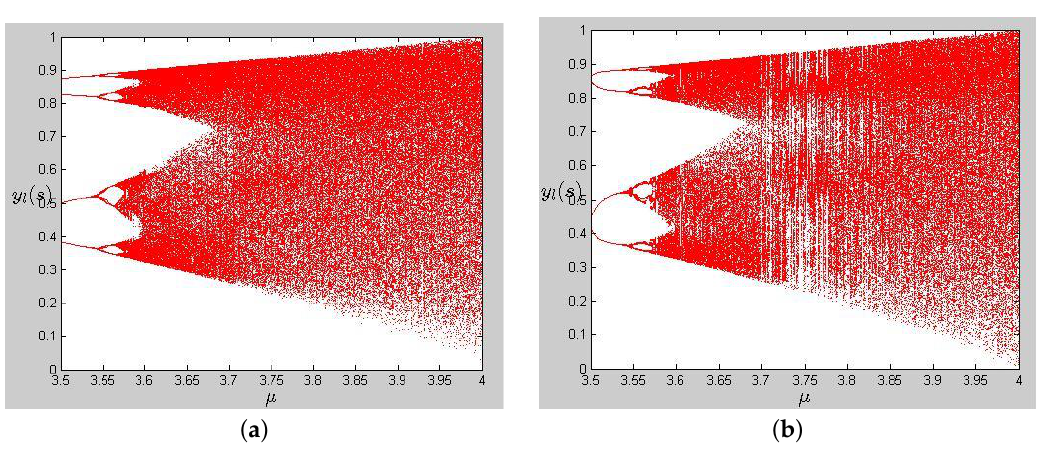
Figure 1. Bifurcation diagram. ( a ) The Non-adjacent Coupled Map Lattices (NCML) chaotic system; ( b ) the CML chaotic